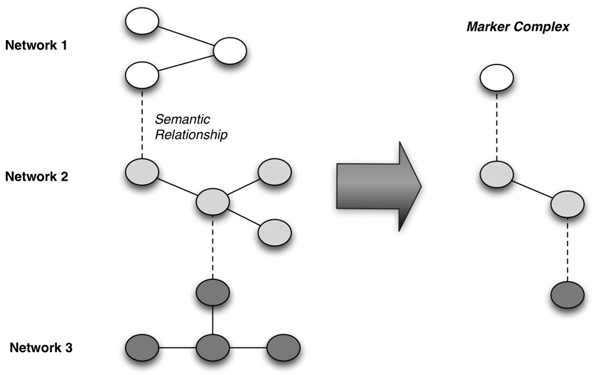
Illustration of heuristically derived conceptual model for multi-dimensional marker complex induction and aggregation.